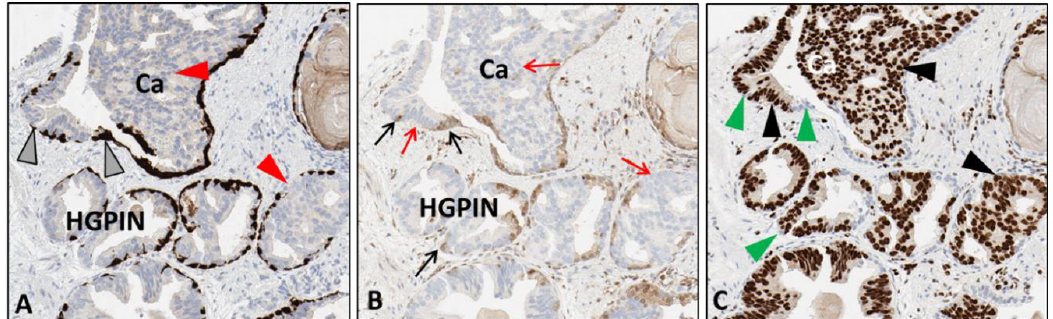
Figure 2. Sequential slides of human prostate tissue exhibiting cancer (Ca) invading into normal glands and high-grade prostatic intraepithelial neoplasia (HGPIN). There is an aggressive carcinoma invading glandular structures that have retained normal basal cells. The retained basal cells are positive for HMWCK + p63 ( A ) (grey arrowheads), positive for phosphatase tensin homolog (PTEN) ( B ) (black arrows), and negative for ETS-Related Gene (ERG) ( C ) (green arrowheads). The cancer is negative for HMWCK + p63 ( A ) (red arrowheads), PTEN ( B ) (red arrows), but positive for ERG ( C ) (black arrowheads). [10× magnification].